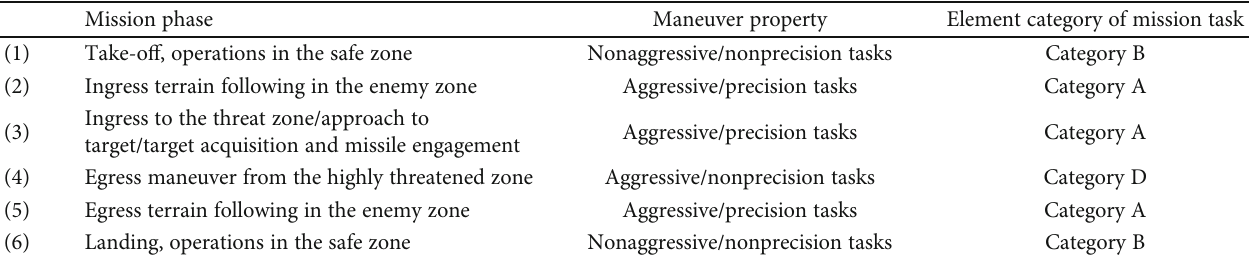
Figure 1: Procedure of the air-to-surface mission Table 1: Maneuver properties of the air-to-surface mission [18].